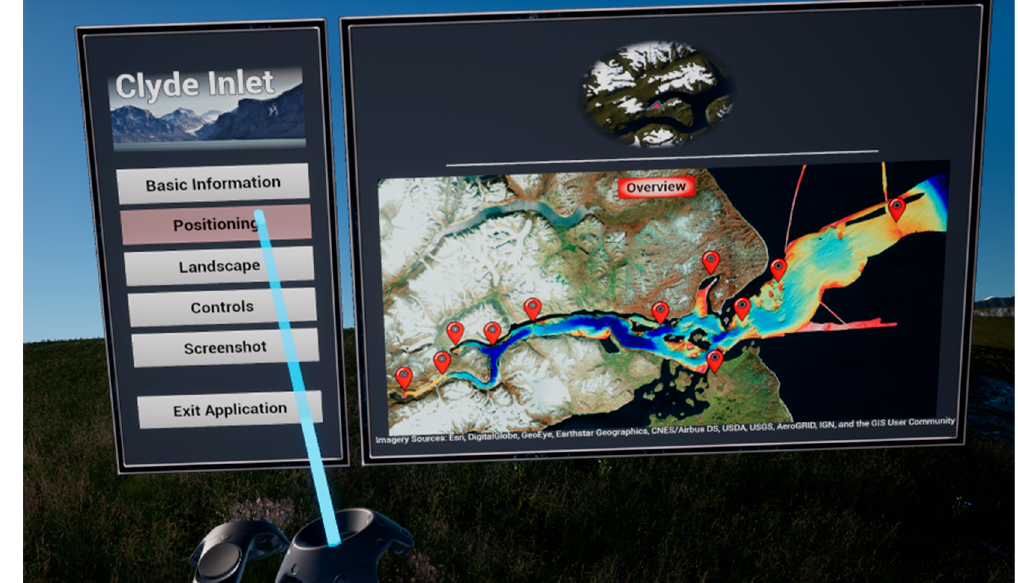
Figure 8. The in-game accessible menu with six different menu pages.